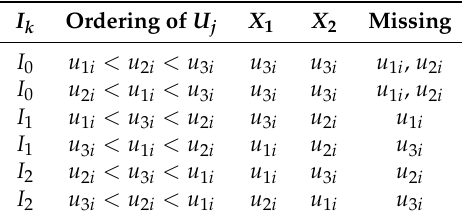
Table 1. Relation between ( x 1 i , x 2 i ) and ( u 1 i , u 2 i , u 3 i ) . I k Ordering of U